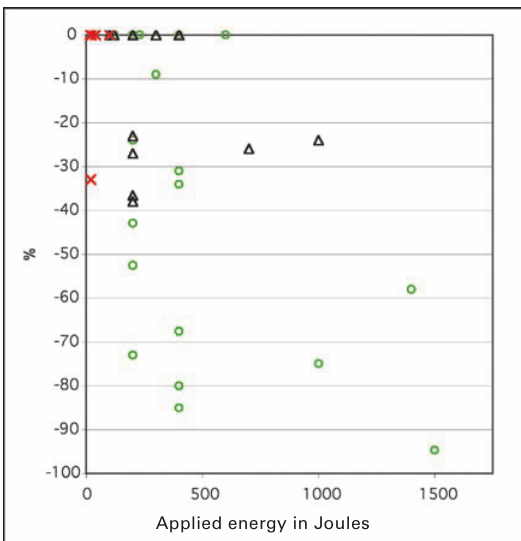
Voltage loss affecting the R wave amplitude in the precordial leads in relation to energy levels used for